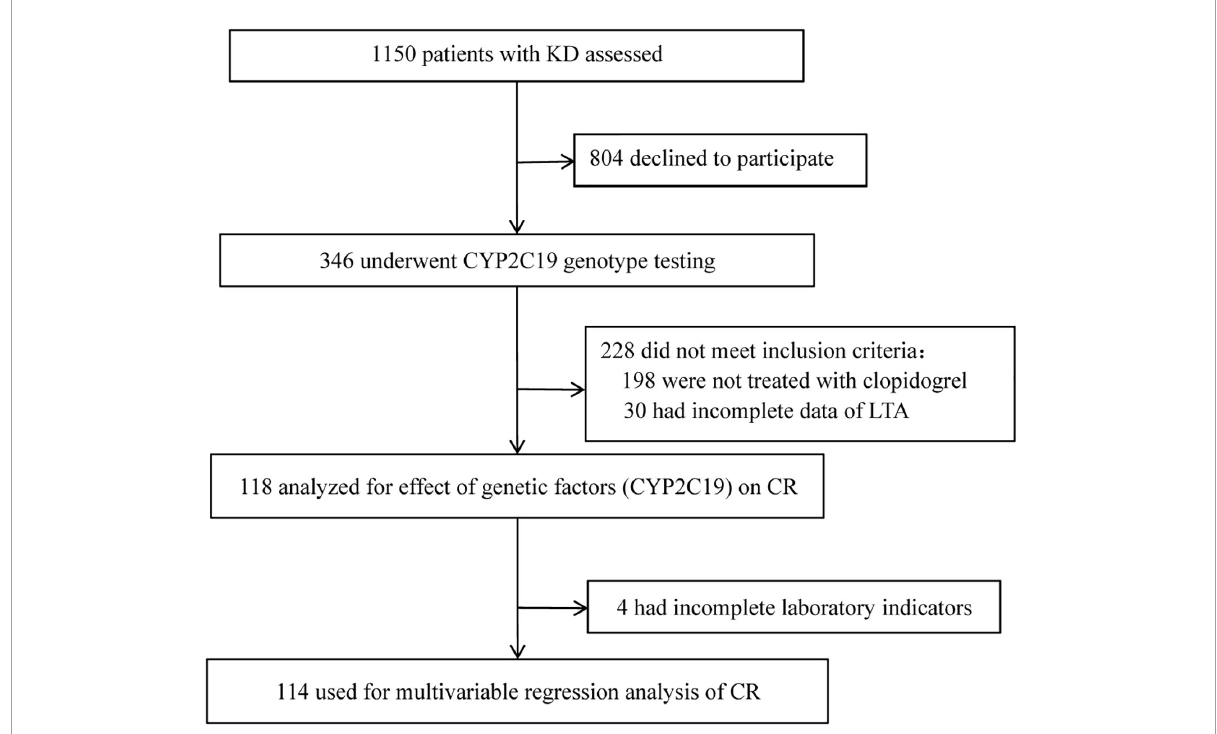
FIGURE1 Flow diagram of the study. KD, Kawasaki disease; LTA, light transmission aggregometry; CR, clopidogrel